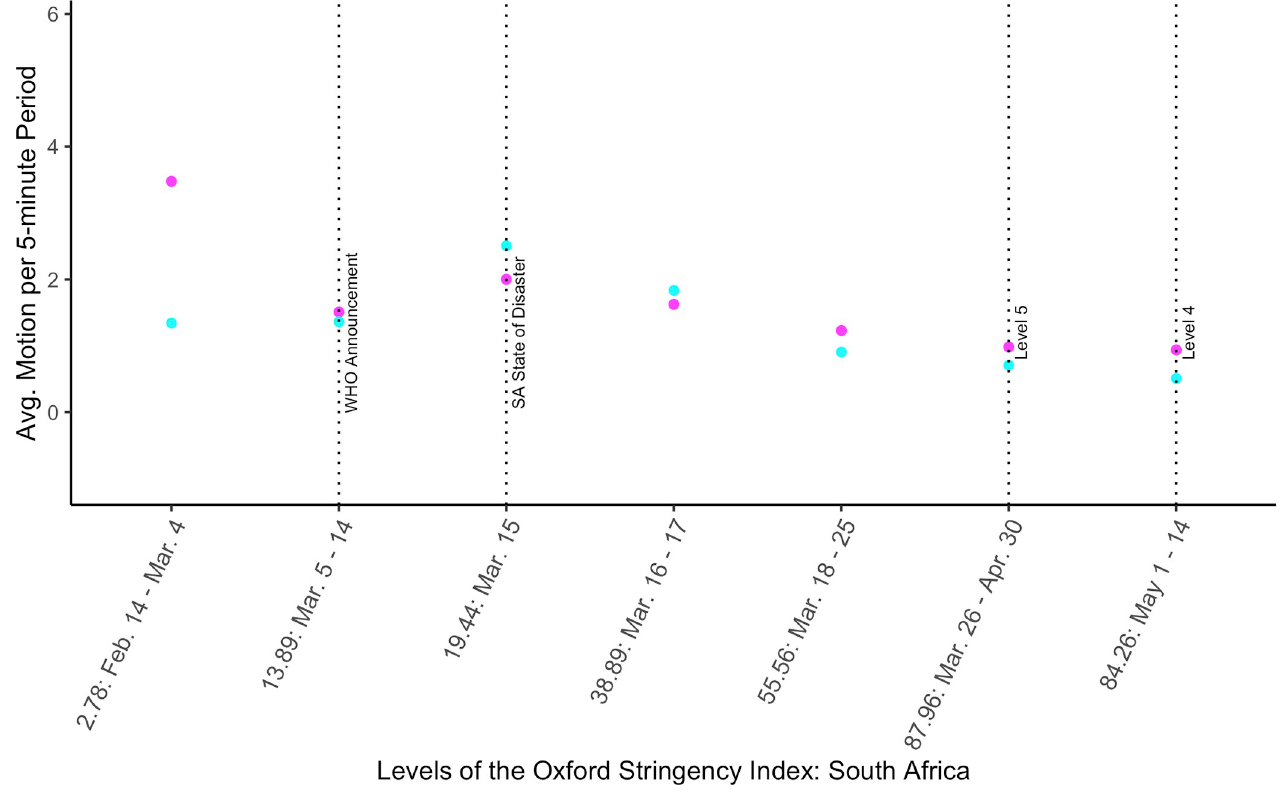
Fig 3. Average 5-minute motion by levels of the Oxford Stringency Index for South Africa. Pink dots represent path averages and blue dots represent compound averages.